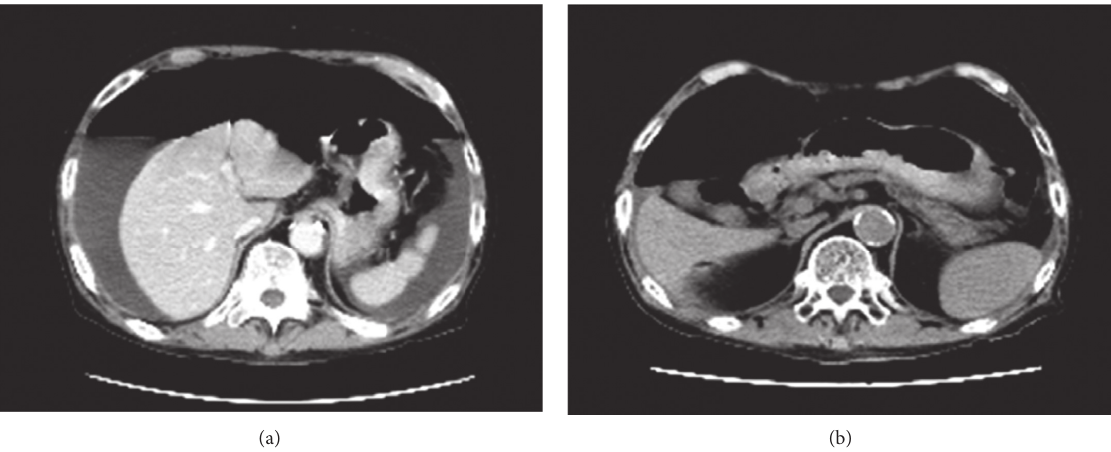
Figure 2: (a), (b) Computed tomography of the abdomen one day after admission. Marked pneumoperitoneum was